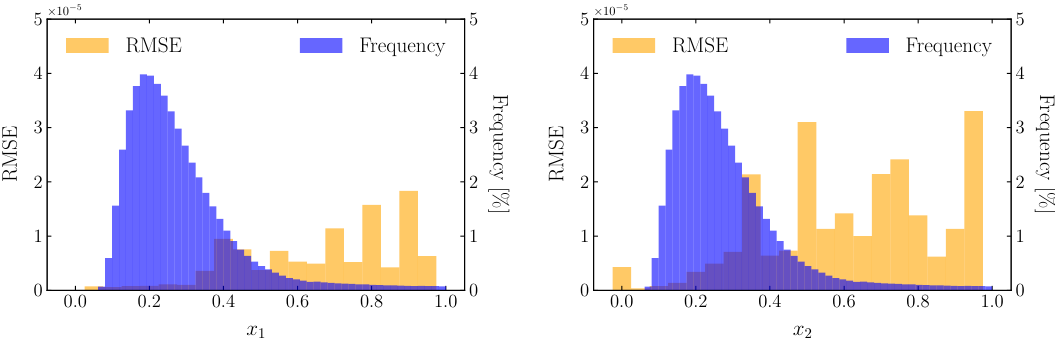
Figure 5. Root mean squared error (RMSE) of the NN ensemble approach in comparison to NJet as a function of x 1 and x 2 , and the frequency of points with these values in the training dataset. of these variables, along with the frequency of points as they appear in the training